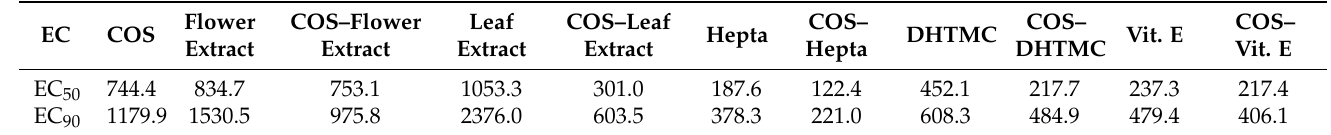
Figure 2. Radial growth of the mycelium for D. seriata in in vitro tests conducted in PDA medium with different concen- trations (in the 62.5–1500 µ g · mL − 1 range) of chitosan oligomers (COS), H. syriacus flower and leaf extracts, their main phytochemical constituents, and their respective conjugate complexes. The same letters above concentrations mean that they are not significantly different at p < 0.05. Error bars represent standard deviations. Table 6. EC 50 and EC 90 effective concentrations of H. syriacus flower and leaf extracts and their phytochemicals against D. seriata , alone and upon conjugation with chitosan oligomers (COS).